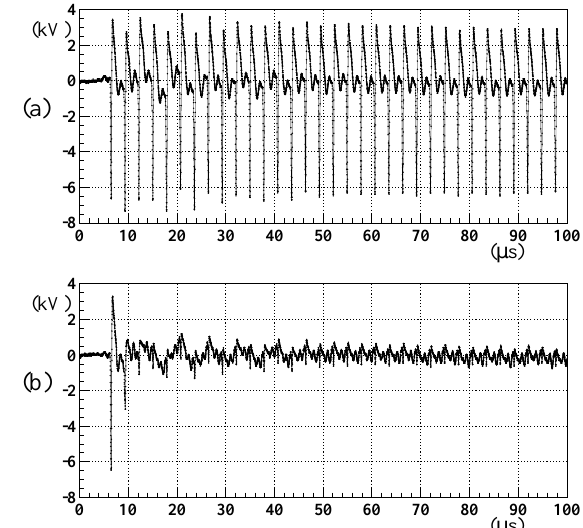
FIG. 4. Induced voltages: (a) without feed forward and (b) with feed forward. The horizontal and vertical coordinates are the time and the voltage per gap, respectively. The beam intensity was 8.2 3 10 12 protons per bunch and one bunch was circulating.